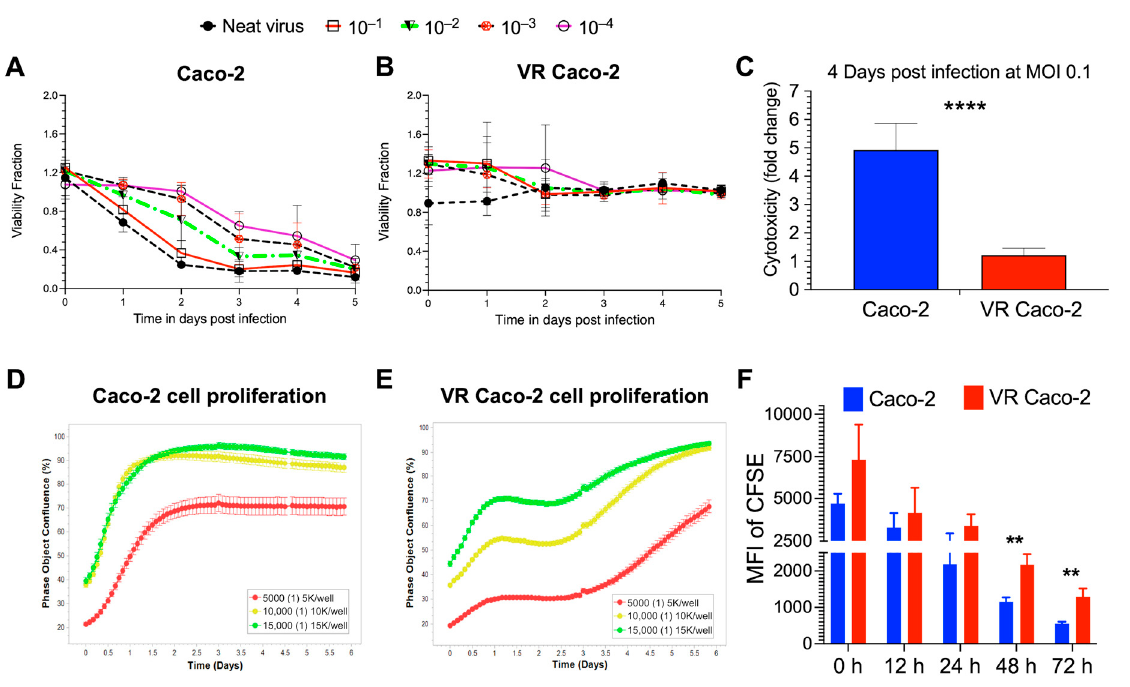
Figure 2. Characterisation of VR Caco-2 and Caco-2 cells. Cell viability measured in NDV B1-GFP neat virus and 10-fold virus dilutions infected ( A ) Caco-2 and ( B ) VR Caco-2 cells in a 5-day virus killing curve assay. NDV reinfection experiments demonstrated resistance in VR Caco-2 cells. ( C ) Cell cytotoxicity assay of 0.1-MOI NDV B1-GFP-infected Caco-2 and VR Caco-2 cells 4 days post-infection demonstrated reduced cytotoxicity of VR Caco-2 cells. Cell proliferation assays showing ( D ) Caco-2 and ( E ) VR Caco-2 cell confluence monitored in real time using the Incucyte imaging system at different seeding densities. Phase object confluence (%) represents the surface area covered by cell monolayer in the culture plate. ( F ) Mean fluorescence intensity (MFI) of CFSE-stained Caco-2 and VR Caco-2 cells at different proliferation time points. CFSE dilution is significant at 48 h and 72 h in Caco-2 cells, indicating greater numbers of cell divisions than VR Caco-2 cells. Data (mean ± SD) shown here are from three independent experiments and analysed using multiple non- parametric t -tests (****: p < 0.0001; **: p < 0.01). Similar to the microscopic observation of slower VR Caco-2 cell growth compared to the uninfected Caco-2 cells, cell proliferation assays by real-time monitoring of the cell confluence confirmed the slower proliferation of VR Caco-2 cells (Figure 2D,E). Caco-2 cells entered the log phase after less than 12 h in the lag phase and reached more than 90% confluence in 1.5 days after being seeded at 10,000 and 15,000 cells/well, at which point they entered the stationary phase. A similar pattern was seen in 5000 cells/well that had reached 70% confluence and had begun stationary development (Figure 2D). Contrarily, VR Caco-2 cells entered the exponential phase after around three days in the lag phase across all three densities, regardless of confluence. At all cell densities, VR Caco-2 cells displayed a distinct growth phase curve from Caco-2 cells. It took VR Caco-2 cells 5.5 days to reach >90% cell confluence at seeding densities of 10,000 and 15,000 cells/well (Figure 2E). The CFSE cell proliferation experiment confirmed that the growth of VR Caco-2 cells was twice as slow as that of Caco-2 cells at 48 and 72 h after CFSE labelling (Figure 2F). Notably, VR Caco-2 cells displayed similar morphology in the cell culture monolayers as the Caco-2 cells. 3.3. Persistent VR Caco-2 Can Be Identified by Metabolic Profiles at Single-Cell Level Despite initially being the most susceptible cell line for NDV-induced oncolysis, Caco-2 cells developed infection persistence in a small population of VR Caco-2 cells. To understand whether the metabolic profiles can be discriminated in the two groups of cells